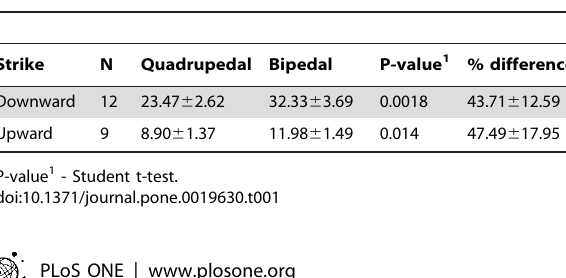
Table 1. Mean values and standard errors of work (J) done during striking downward and upward from ‘‘quadrupedal’’ and bipedal